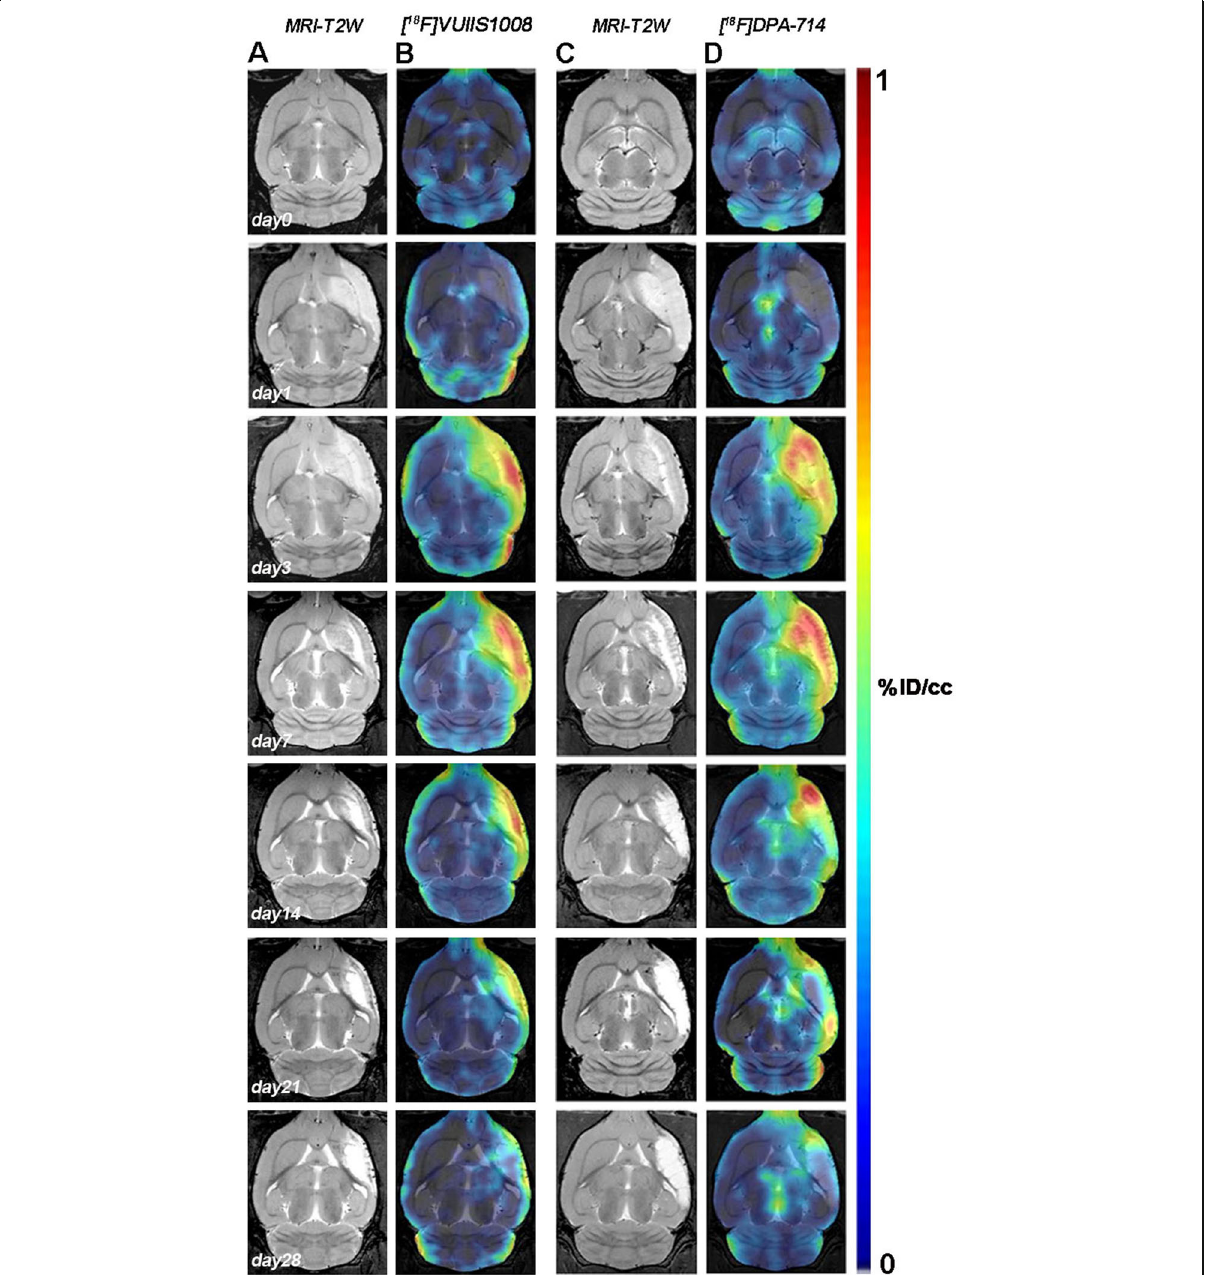
Fig. 3 Magnetic resonance imaging (MRI) (T2-weighting (T 2 W)) and positron-emission tomography (PET) images of [ 18 F] VUIIS1008 and [ 18 F] DPA-714 at control (day 0) and days 1, 3, 7, 14, 21, and 28 after the middle cerebral artery occlusion (MCAO). Serial MRI (T 2 W) ( a , c ) and TSPO PET binding ( b , d ) images of horizontal planes at the level of the lesion are shown. PET images are co-registered with the MRI (T 2 W) of the same animal at different times to localize the PET signal. Images correspond to the lesion evolution of the same animal over